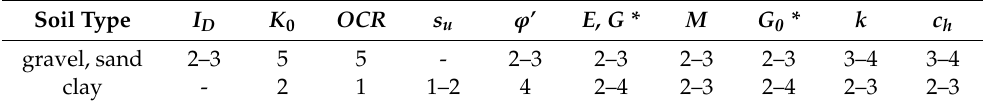
Table 1. Usability of CPTu method to determine the soil parameters [14].